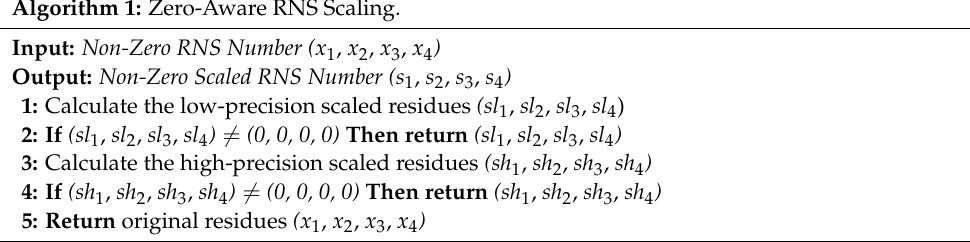
Algorithm 1: Zero-Aware RNS Scaling.